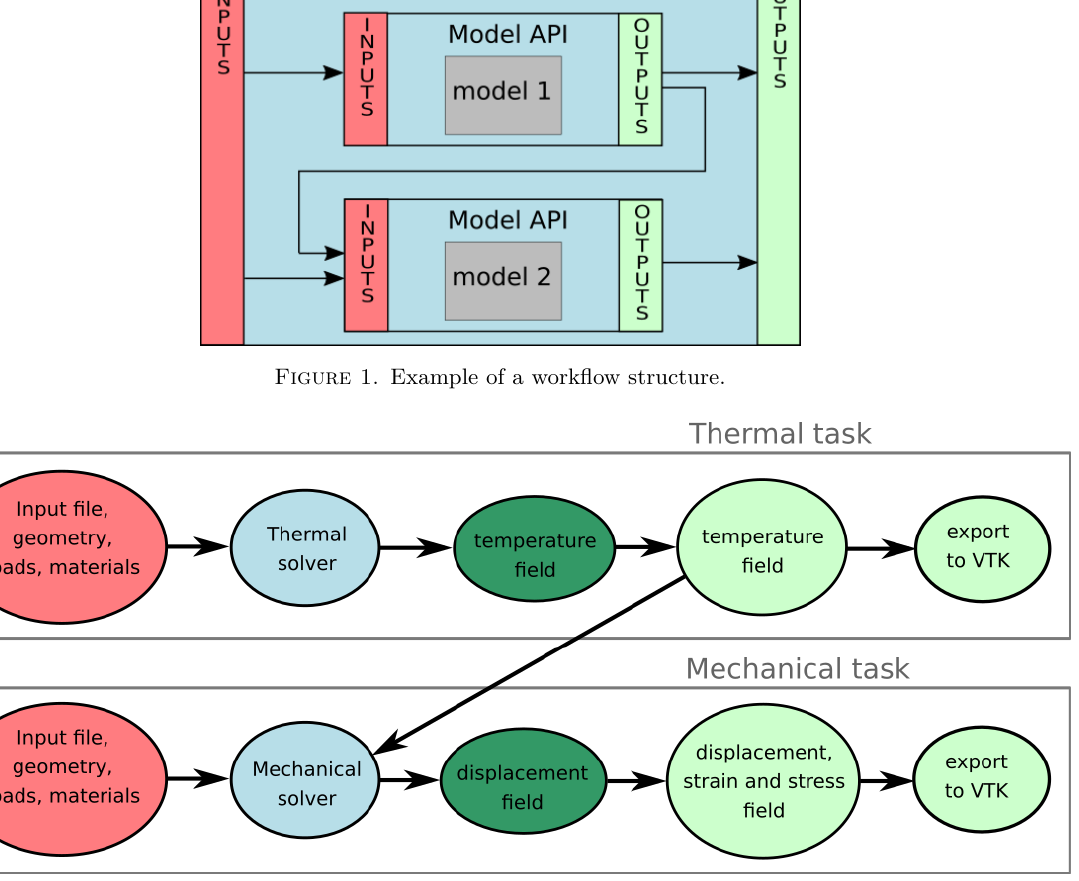
Figure 2. Workflow diagram of a thermo-mechanical